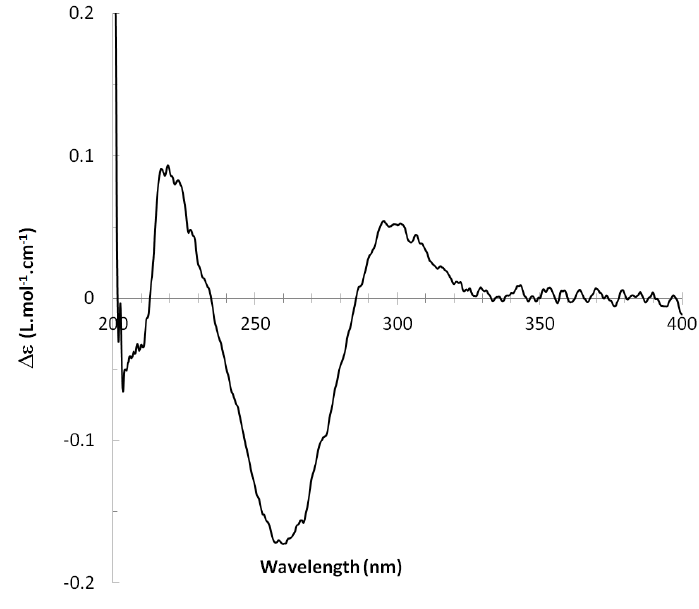
Figure 4. Experimental ECD spectrum of dodovisate C ( 1 ).